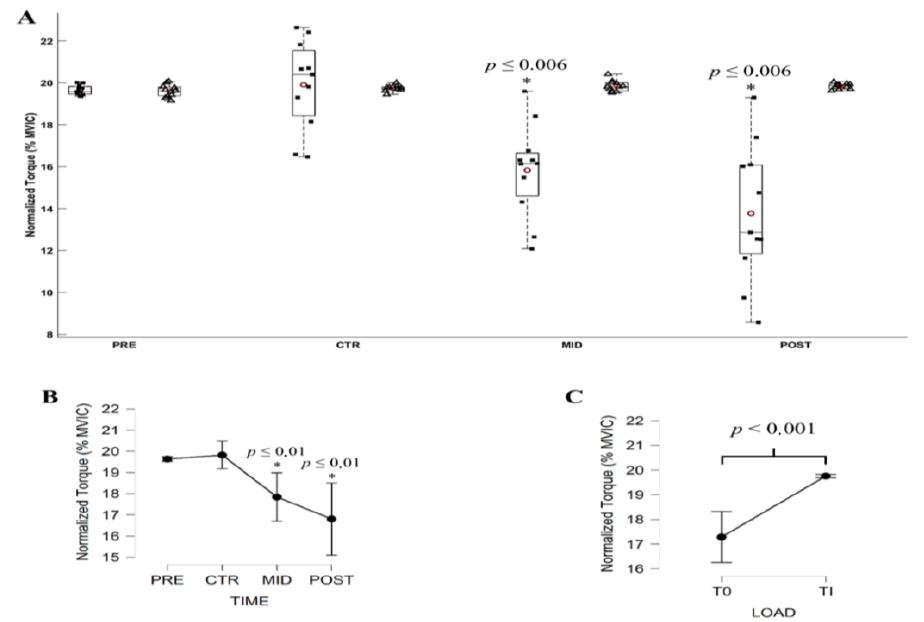
Figure 4. ( A ) Average normalized torque (% MVIC) during submaximal contractions computed according to the torque levels, T 0 (black square) and Ti (white triangle), and evaluation sessions (PRE, CTR, MID, POST sessions). Each whiskers box indicates the mean (red circle) and the median (horizontal line). The inferior and superior edges of the box indicate the 25th and 75th percentile, respectively. Black dots represent individual participant performance. ( B ) Average normalized torque (N.m) during submaximal contractions computed according to evaluation sessions and ( C ) to the torque levels. Error bars represent the most extreme and non-outlier data points ( A ) and 95% confidence intervals ( B , C ). * significantly different from all other conditions.